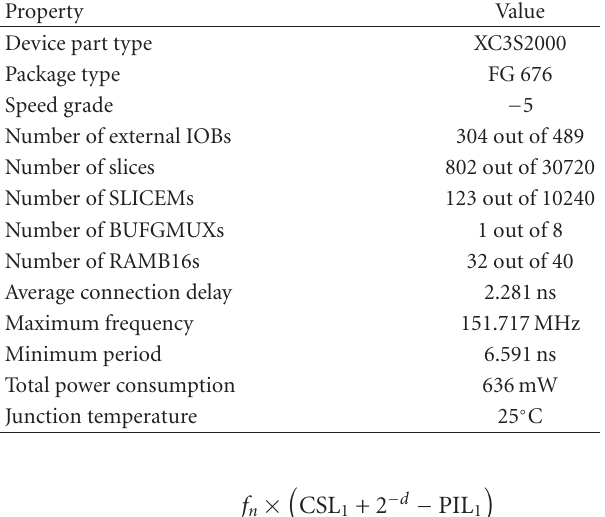
Table 3: Synthesis